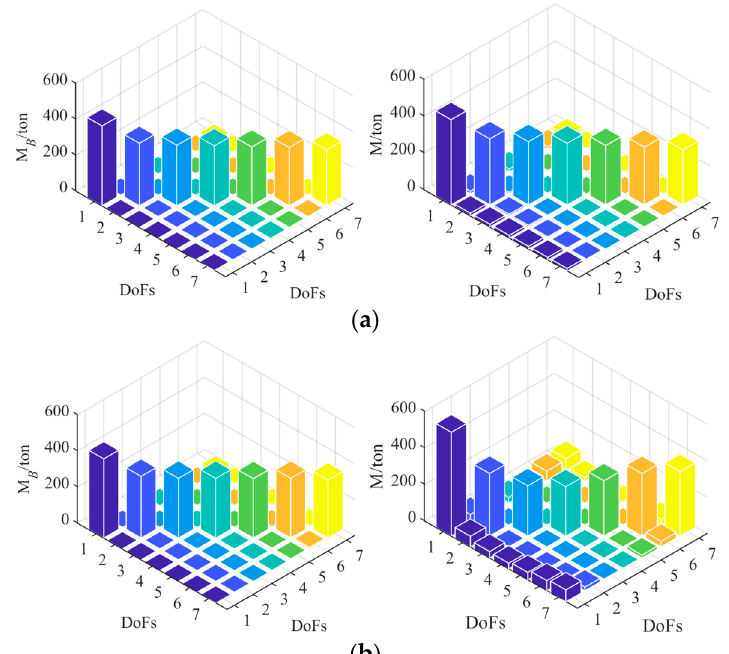
Figure 6. Updated mass matrices by Equations (13) and (27): ( a ) updating results by using the first mode; ( b ) updating results by using the first two modes.